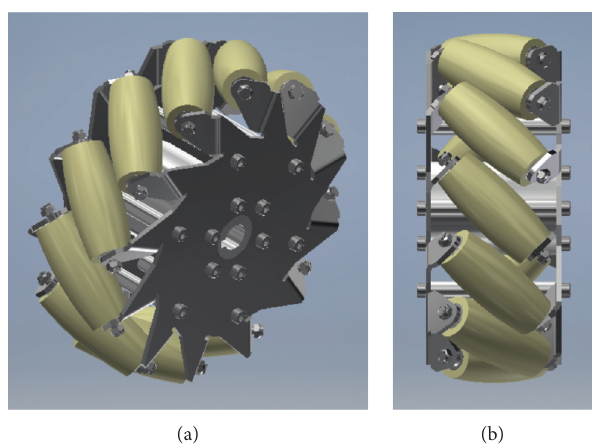
Figure 10: (a) Isometric and (b) front view of the mecanum wheel.